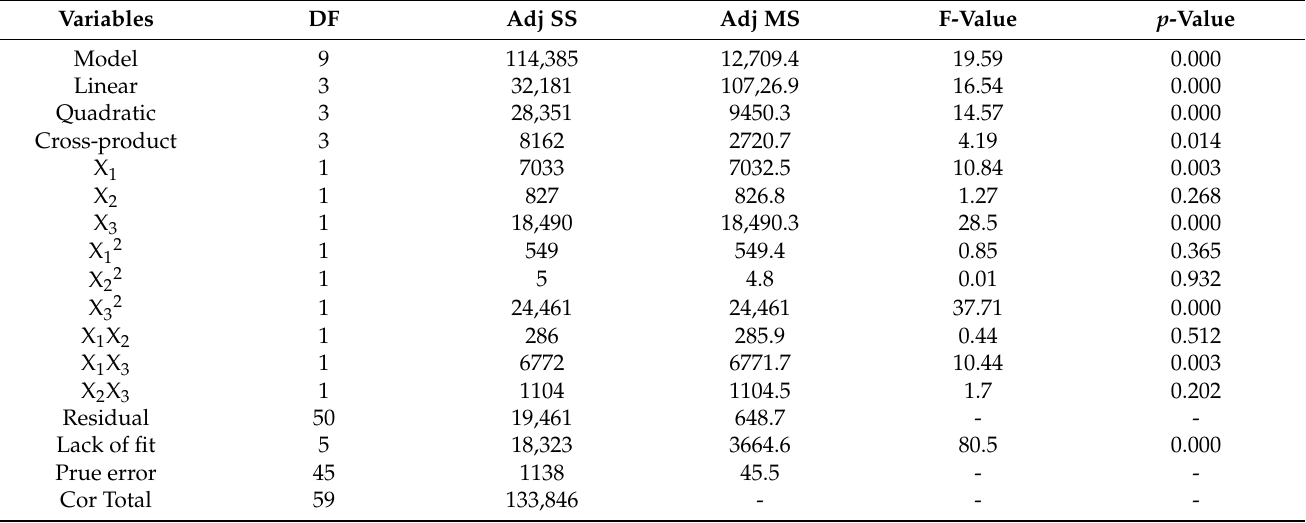
Table 3. Analysis of variance of the experimental results using a central composite